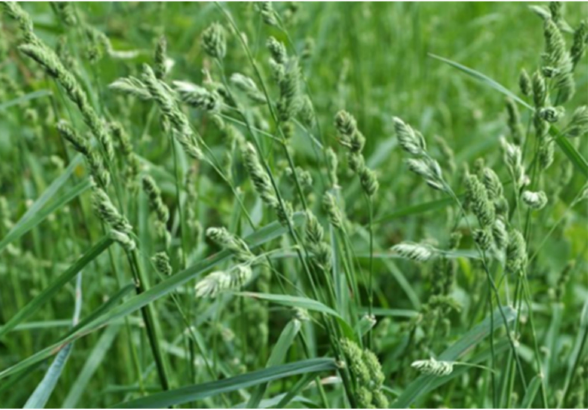
Figure 2. Cocksfoot ( Dactylis glomerata L.) Variety Dabrava. Author’s photos of Prof. A. Katova.